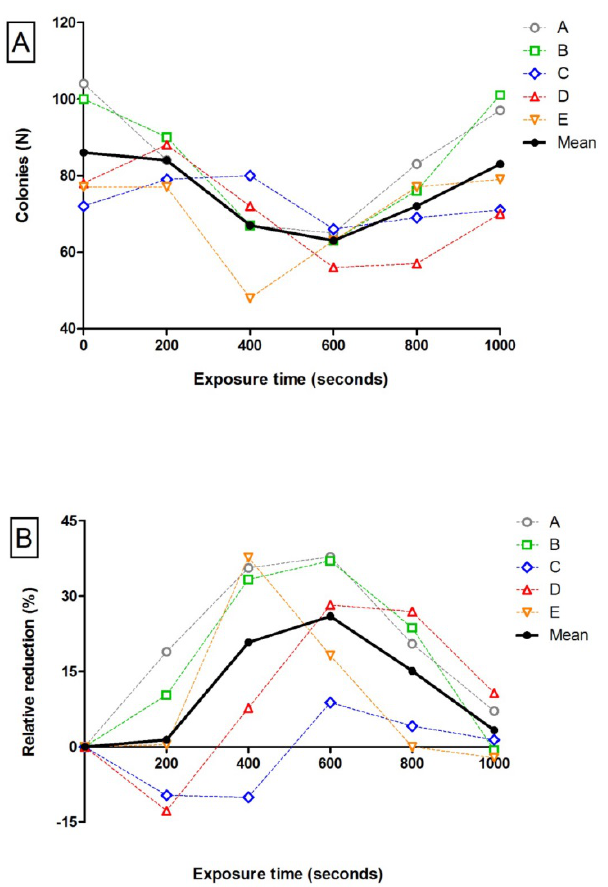
Figure 4. Colony counts and colony reductions per exposure time. A: Colony counts for control plates and after the five exposure times. B: Relative reduction rates compared with control plates for the five exposure times. Data are shown as N. The black line shows the average of the measurements in series A to